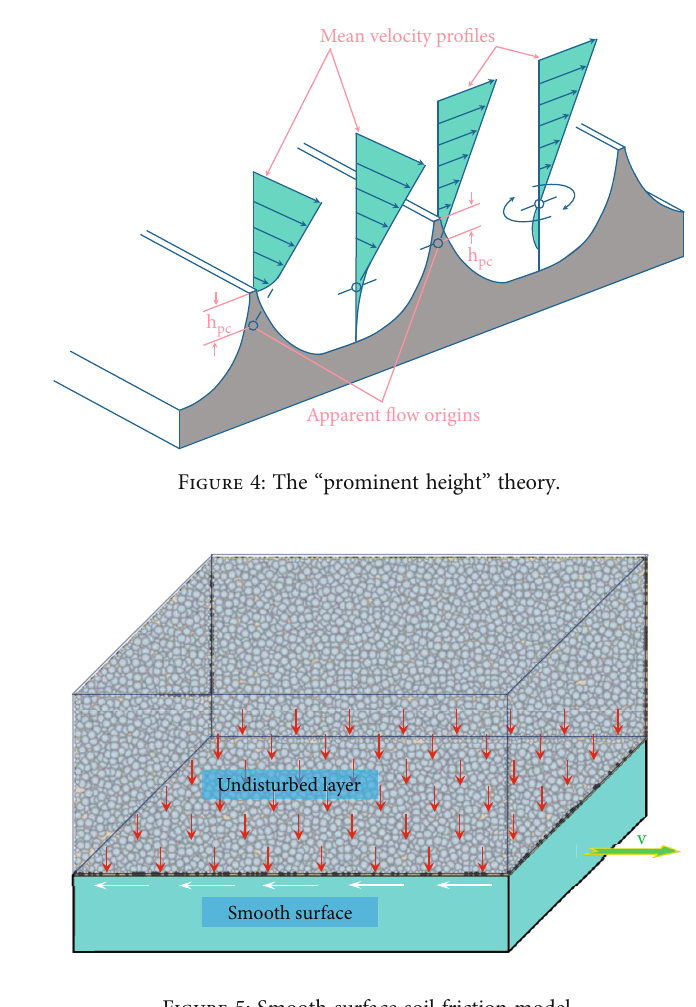
Figure 5: Smooth surface soil friction